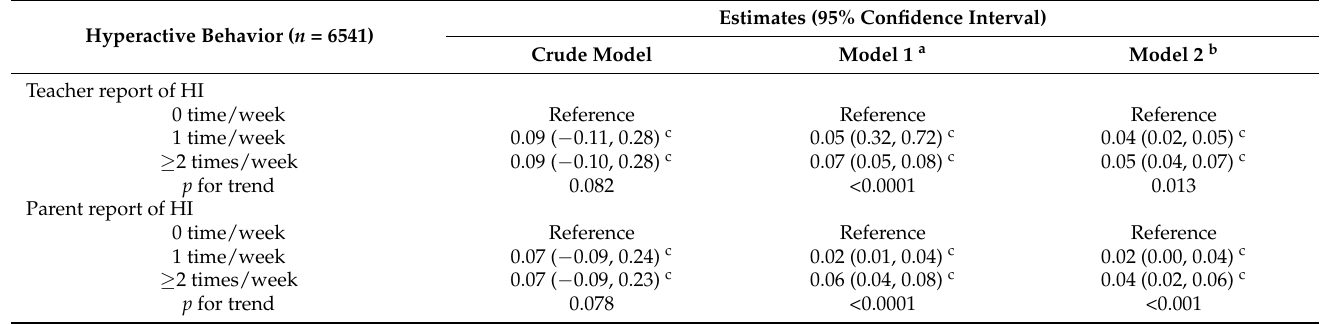
Table 2. Association between SSB with hyperactive